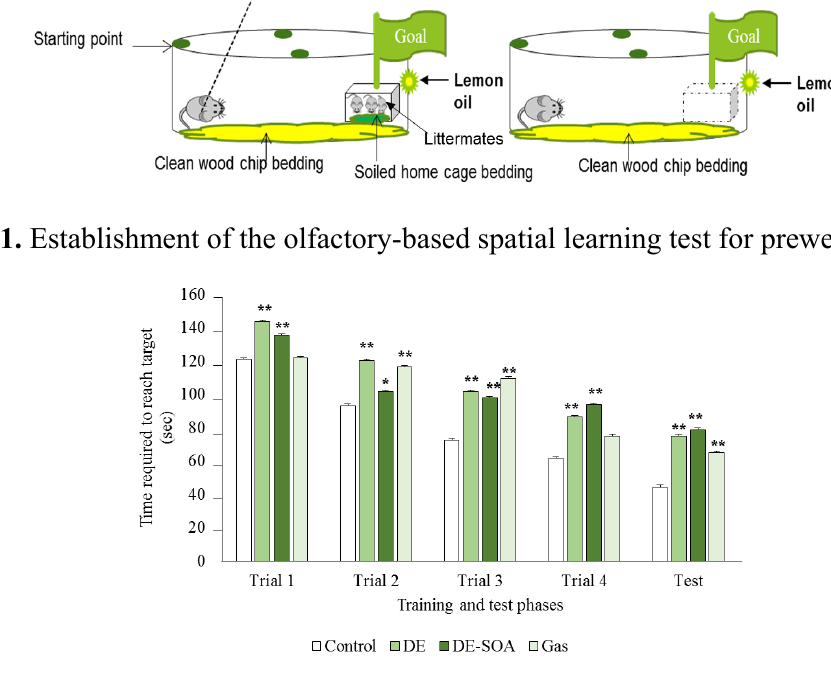
Figure 2. Effects of diesel exhaust (DE) or DE-SOA (secondary organic aerosols) on olfactory-based spatial learning ability in preweaning mice. ( n = 8–10, ** p < 0.01, * p < 0.05 vs.